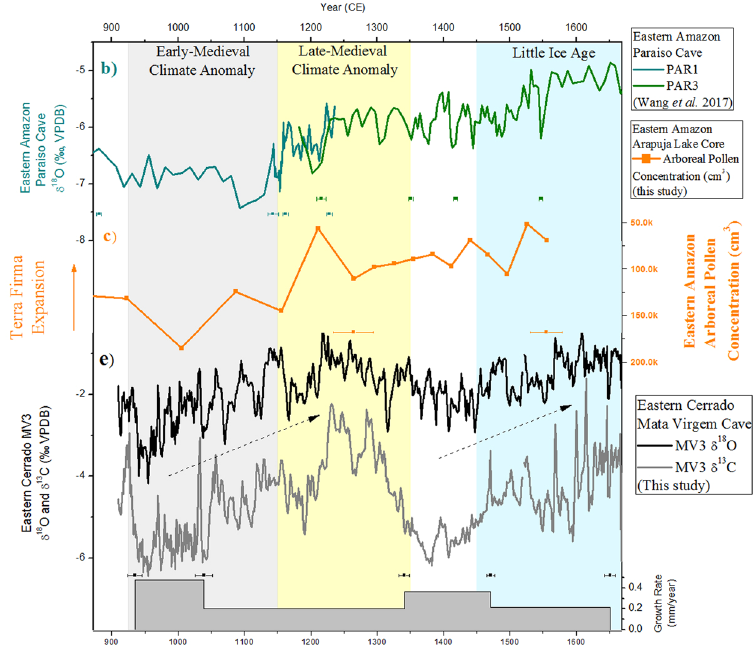
Figure 2. Comparison between Eastern Amazon and Eastern Cerrado records. ( b ) Paraíso Cave – PAR1 and PAR3 records – Eastern Amazon 9 , ( c ) Arapujá Lake Arboreal palynomorphs concentration (cm 3 ) from lacustrine core – Eastern Amazon (this study) and ( e ) Mata Virgem cave – MV3 δ 18 O, δ 13 C and growth rate records - (this study) – Eastern